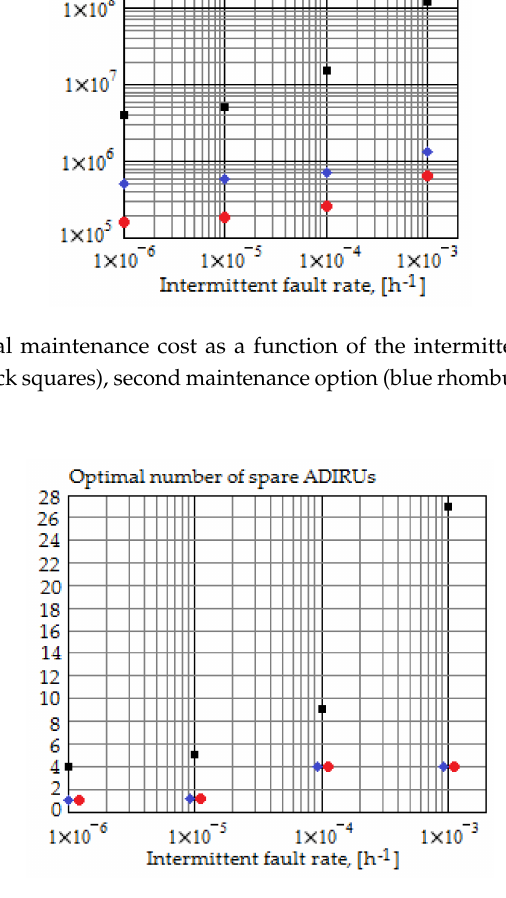
Figure 6. Optimal number of spare ADIRUs as a function of the intermittent fault rate for the first maintenance option (black squares), second maintenance option (blue rhombus), and third maintenance option (red